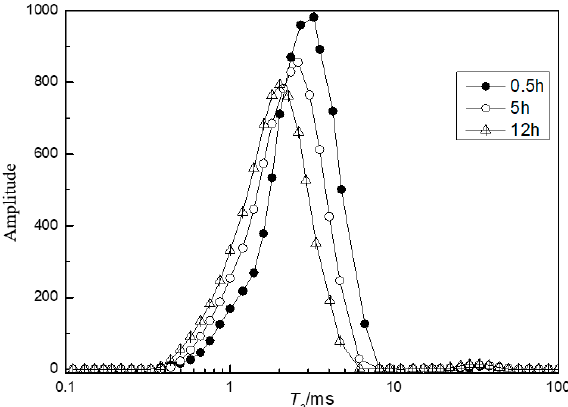
Figure 4. T 2 distribution of cement slurry with DMC content of 10%.